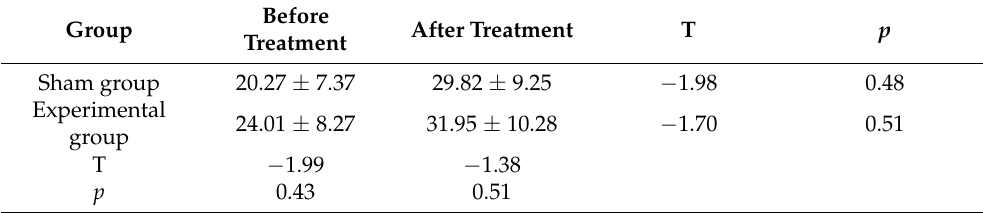
Table 3. The lower limb Fugl–Meyer assessment. Group